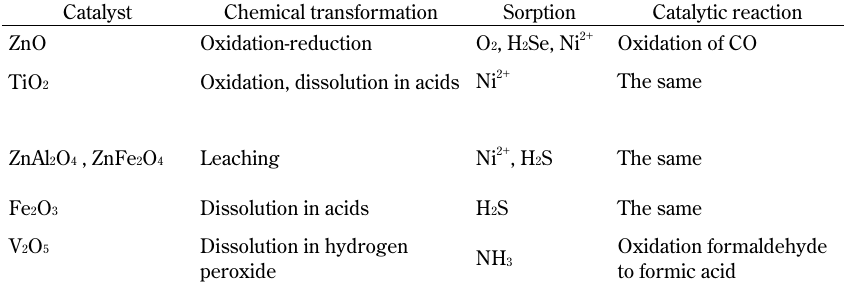
Table 1 Influenceofdefectsinthecatalyststructureonchemicalprocesses